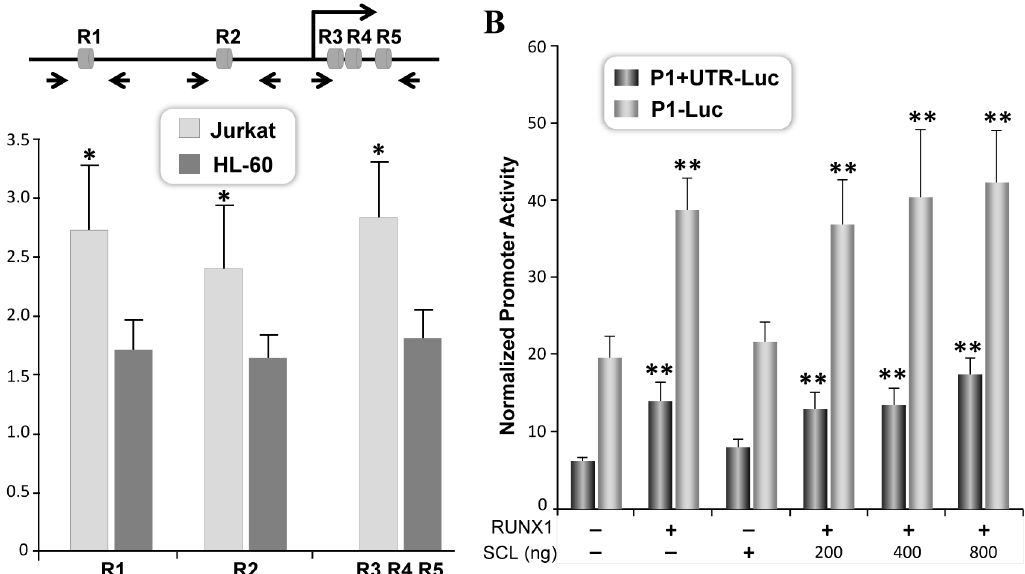
Fig 7. SCL is recruited to regions containing RUNX motifs in the promoter and the UTR. A) Chromatin from Jurkat and HL-60 cells were immunoprecipitated with SCL antibody. DNA regions containing indicated RUNX motifs were amplified by qPCR. Mean values of SCL immunoprecipitated DNA from three independent experiments and three replicates were obtained for each site. Data is presented as fold changes over IgG in Jurkat and HL-60 cells. Statistically significant occupancy of SCL in promoter region containing RUNX motifs was observed only in Jurkat cells ( * p < 0.1) B) HeLa cells were cotransfected with either P1+UTR-Luc or P1-Luc and 200ng of RUNX1 and SCL expression vectors. For co-expression 200ng of RUNX1 was transfected with increasing amounts of SCL expression vector. Luciferase activity was determined 18h later and values normalized with Renilla luciferase used as internal control. Normalized data pooled from three independent experiments each performed in triplicate, is presented with standard error of the mean. Statistically significant changes in RUNX1 promoter activity is indicated by asterisks ( ** p <